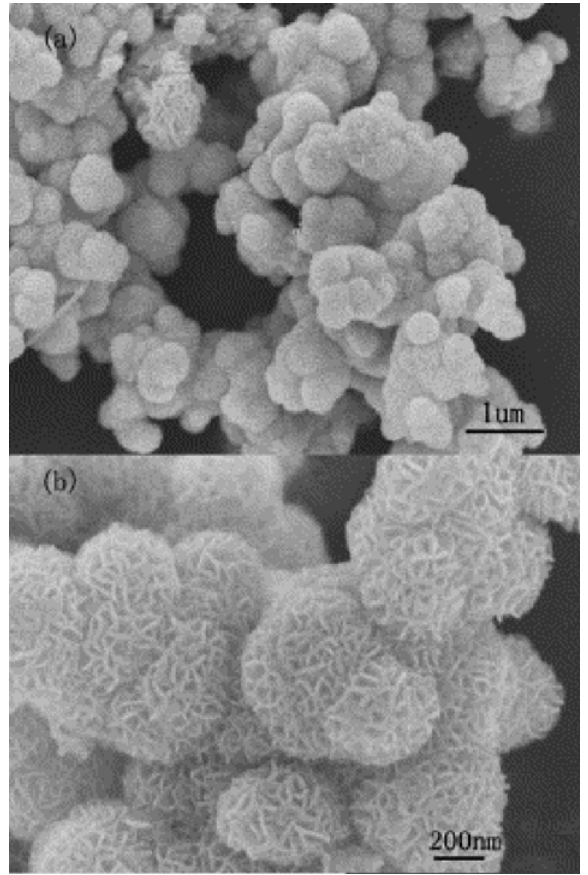
Figure 2. Morphology of the submicrometer MoS Reproduced from reference [66] with permission from